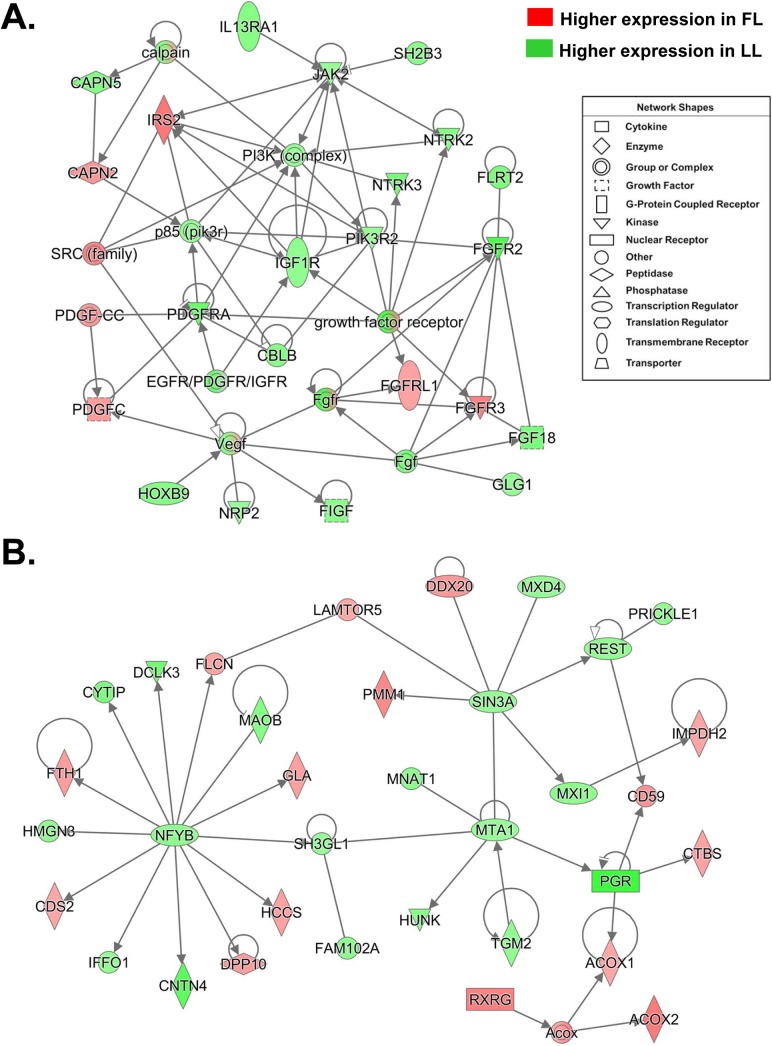
Gene interaction networks involved in growth factor signaling (A) and (B) transcription factor regulation.
(A) This gene network is highly populated by genes involved in growth factor signaling and functionally annotated by IPA as “Cellular Growth and Proliferation, Cell Cycle and Cancer”. (B) This gene interaction network is populated by several transcription factors up-regulated in the LL chickens and functionally annotated by IPA as “Cell Death and Survival, Gene Expression, Cell Cycle”.